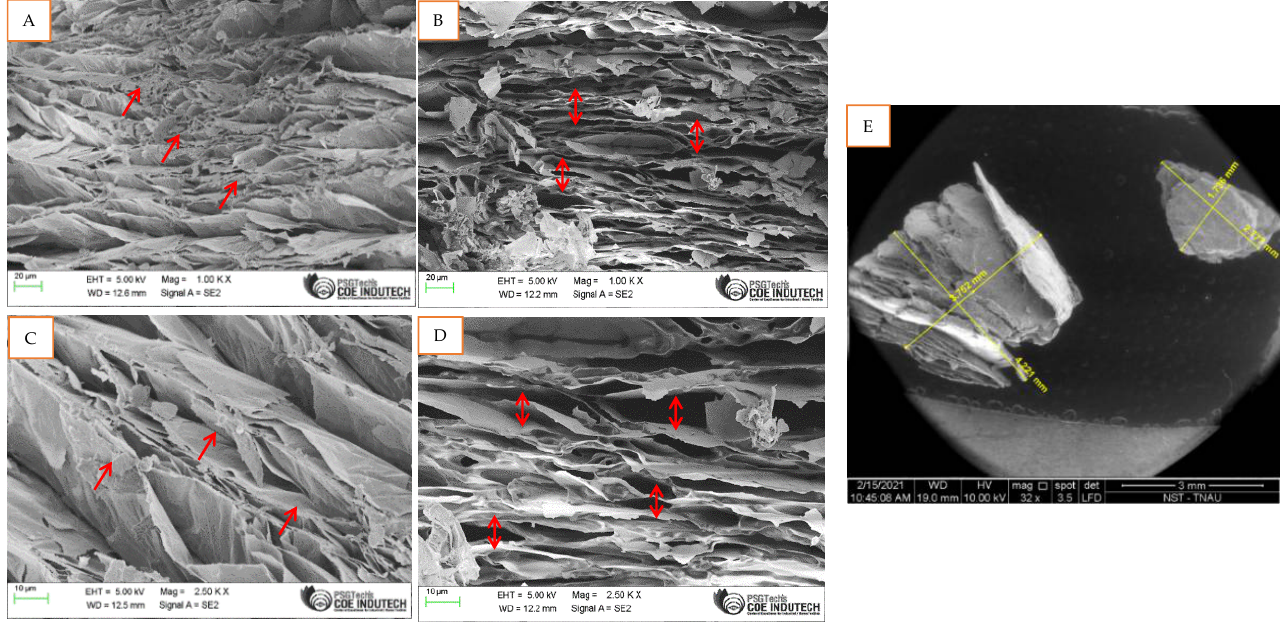
Figure 5. SEM imaging of M. spicata vermiculite ball. 5A and 5C - Control (Without immobilized) at 1.00 KX magnification; 5B and 5D - M. spicata immobilized vermiculite ball at 2.50 KX magnification. The double arrow indicates expanding and the single arrow indicates non-expanding. 5E - Fold change in control (Right) and M. spicata (Left) immobilized vermiculite ball.